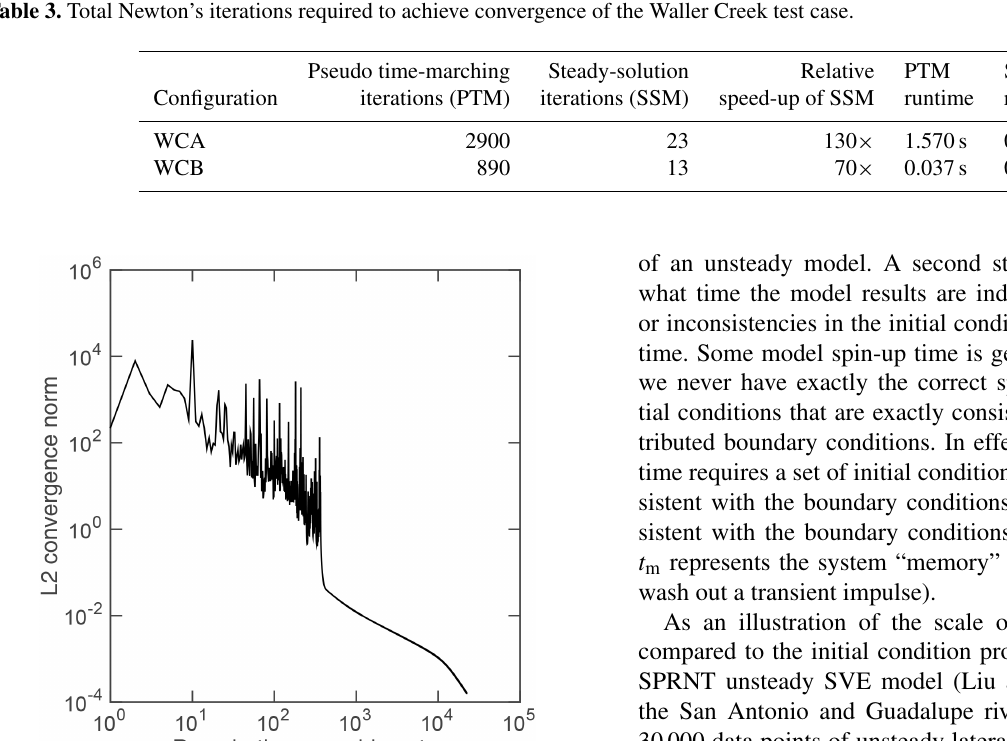
Table 3. Total Newton’s iterations required to achieve convergence of the Waller Creek test case.